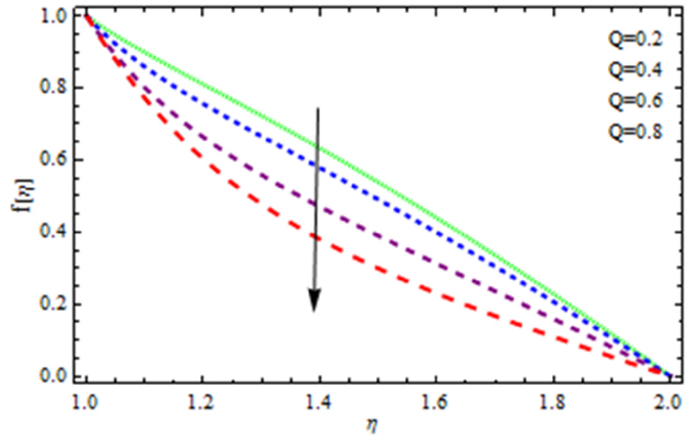
Figure 10. Influence of D on the velocity curve in the case of Vogel’s model.